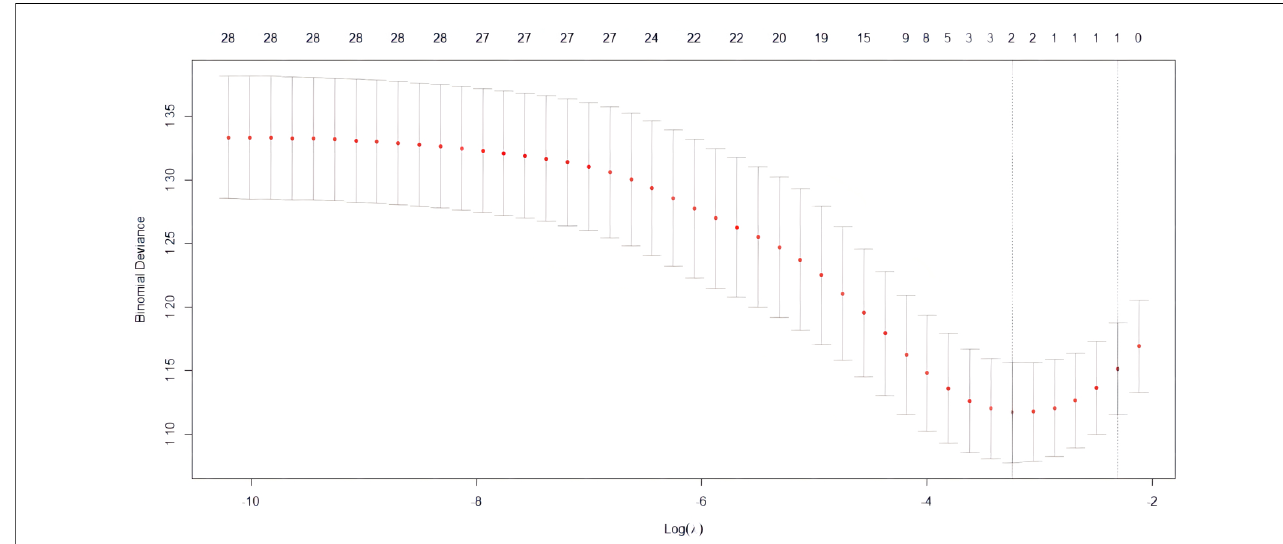
FIGURE 1 The LASSO regularization parameter lambda was selected by 10-fold cross-validation using the cv.glmnet function, and the optimal Lambda value was identi fi ed by the minimum cross-validated criterion and the minimum criterion within one standard